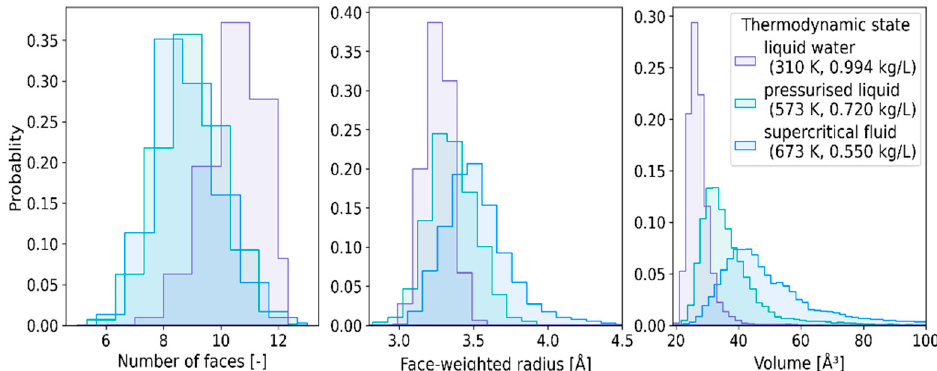
Figure 4. Histograms representing statistical distributions of the number of faces ( left ), face-weighted radius ( central ), and VP-volume ( right ) at the thermodynamic conditions specified in the right panel. Figure 5. Histograms representing the effect of density on the statistical distribution of the number of faces (left), face-weighted radius (central), and VP-volume (right) at the supercritical temperature 673 K.